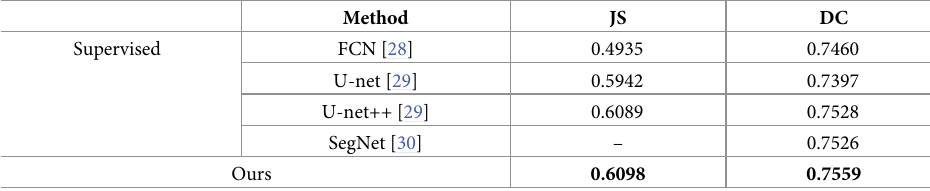
Table 10. MoNuSeg dataset comparison